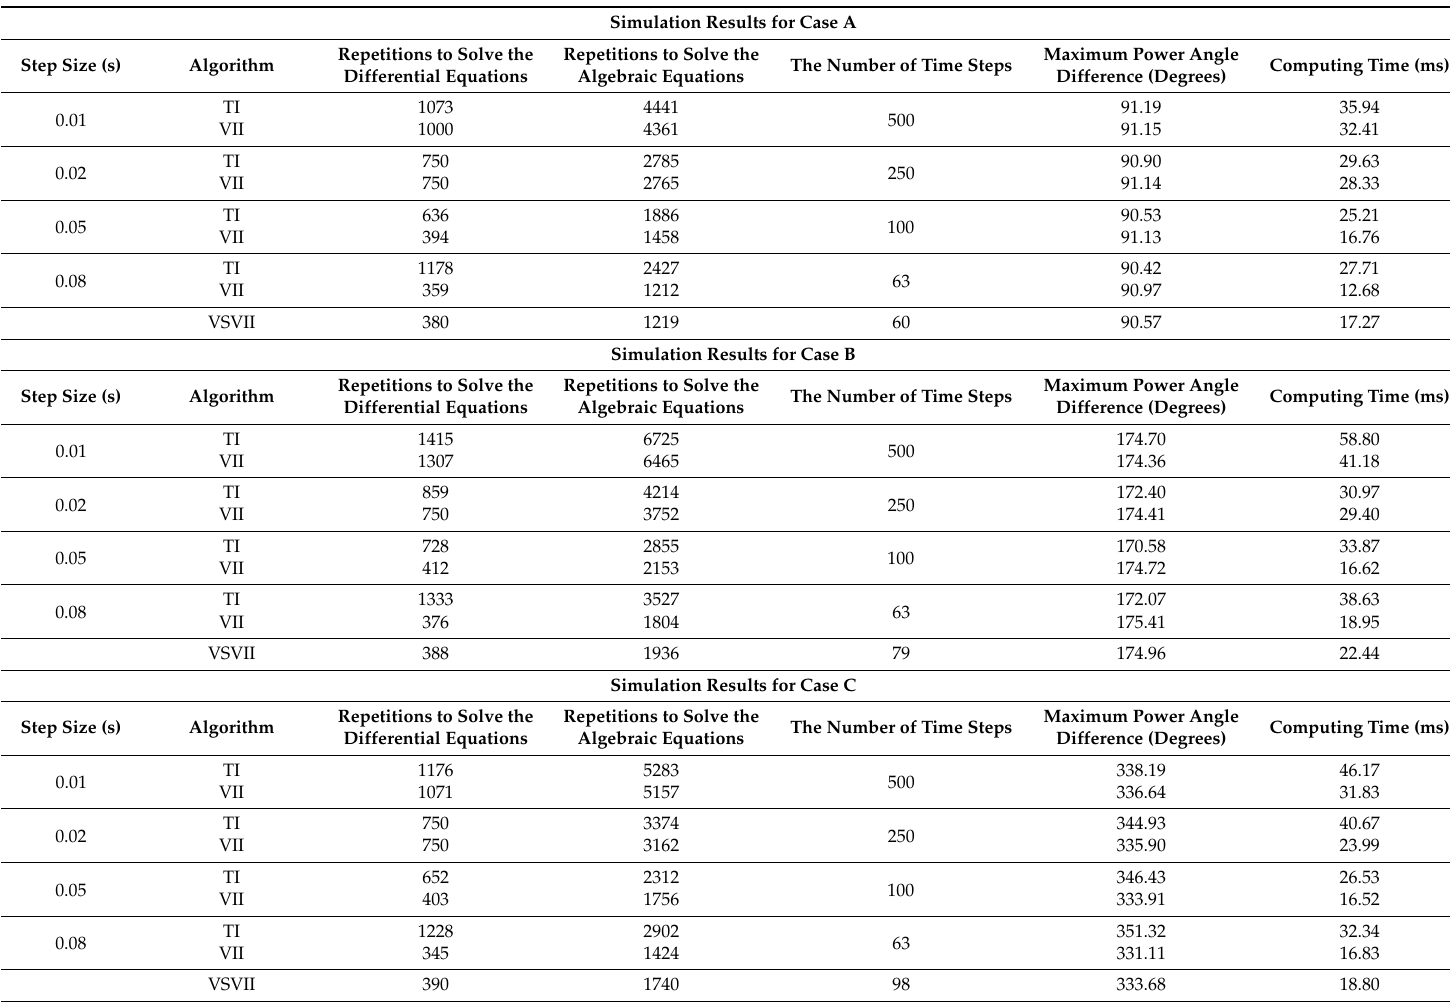
Table 1. Simulation results for the IEEE39